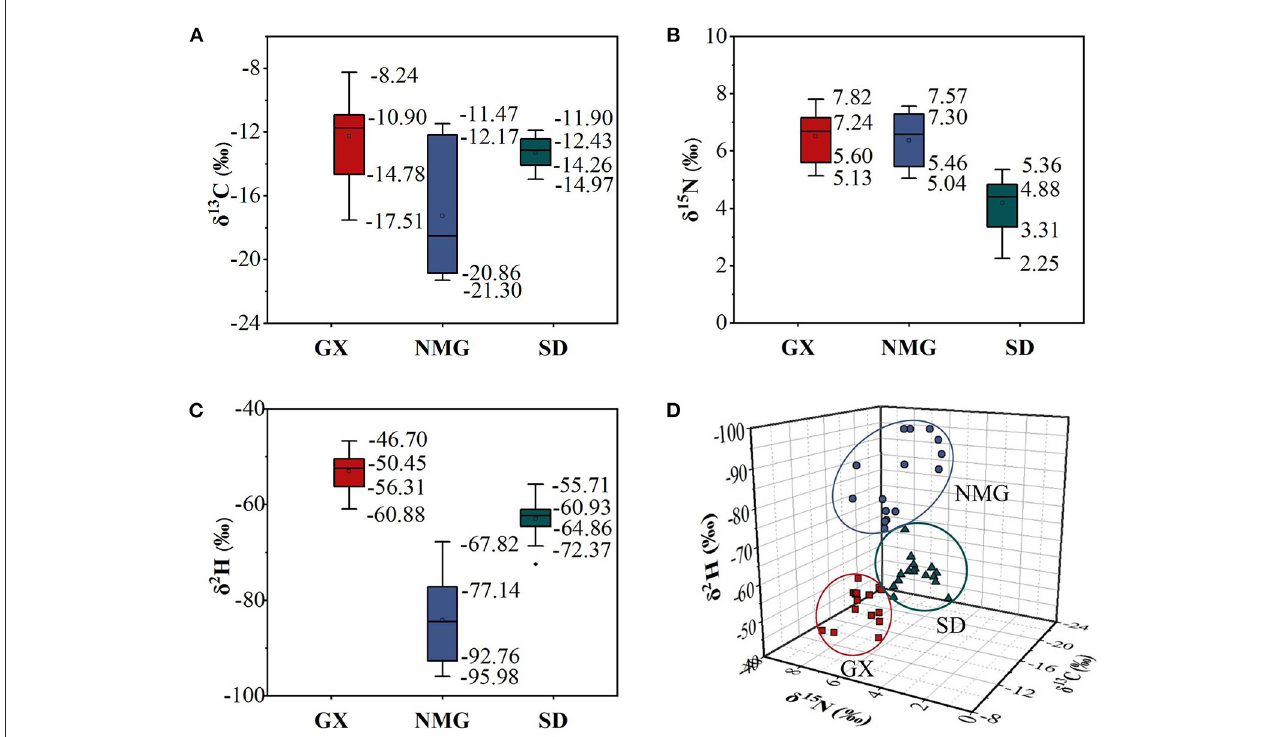
FIGURE4 Boxplots of δ 13 C (A) , δ 15 N (B) , and δ 2 H (C) values in gelatin samples from different regions. (D) Three-dimensional (3D) scatter plots of δ 13 C, δ 15 N, and δ 2 H in three regions.